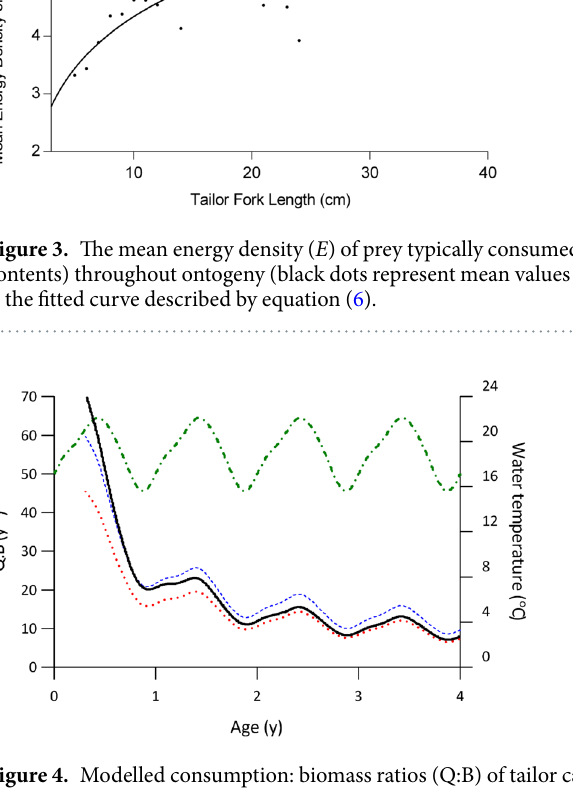
Figure 4. Modelled consumption: biomass ratios (Q:B) of tailor calculated using different prey compositions. A variable prey energy density (solid black), a constant prey energy density based on a 100% sardine diet (high energy content; dotted red), and a constant prey energy density based on a 100% anchovy diet (low energy content; dashed blue). Environmental water temperature is overlayed (dash-dot